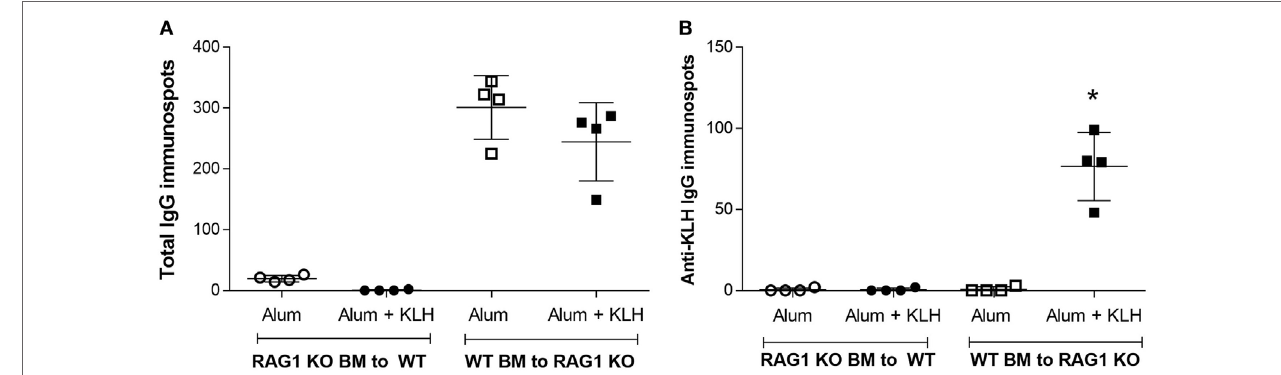
FigUre 8 | Dorsal root ganglion (DRG) sensory neurons from mice with Rag1 -positive hematopoietic cells, but not from mice with Rag1 -negative hematopoietic cells, release antigen-specific IgG. Detection of IgG-releasing cells using the ELISpot assay. Quantification of (a) total IgG and (B) anti-KLH-specific IgG immunospots produced by DRG neurons isolated from alum-injected and alum + KLH-immunized chimeric mice [ Rag1 knock-out (KO) bone marrow (BM) into wild-type (WT) and WT BM into Rag1 KO]. (Mean ± SD, n = 4 per group). * P < 0.05 vs . alum-injected (Mann-Whitney